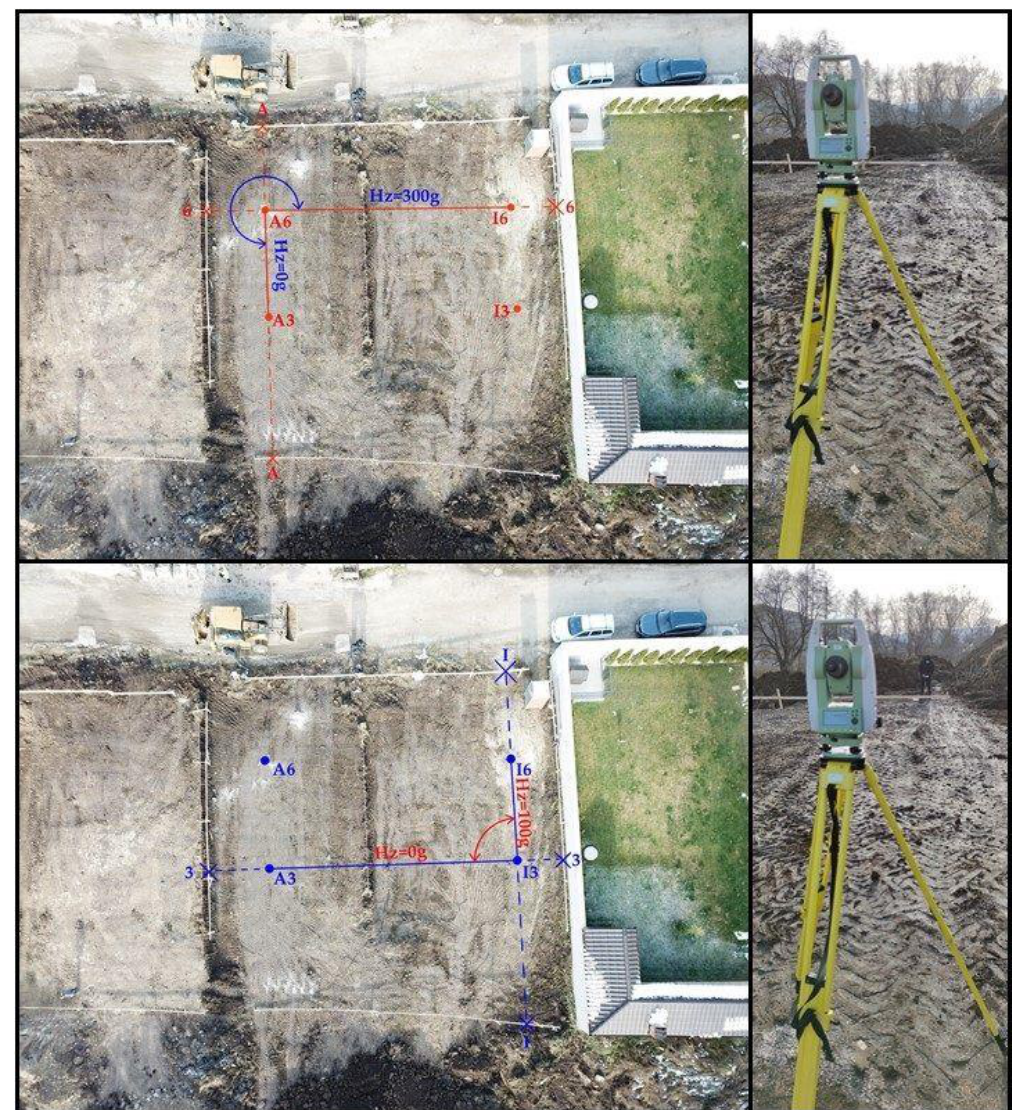
Figure 9. Typical workflow for theodolite method construction line